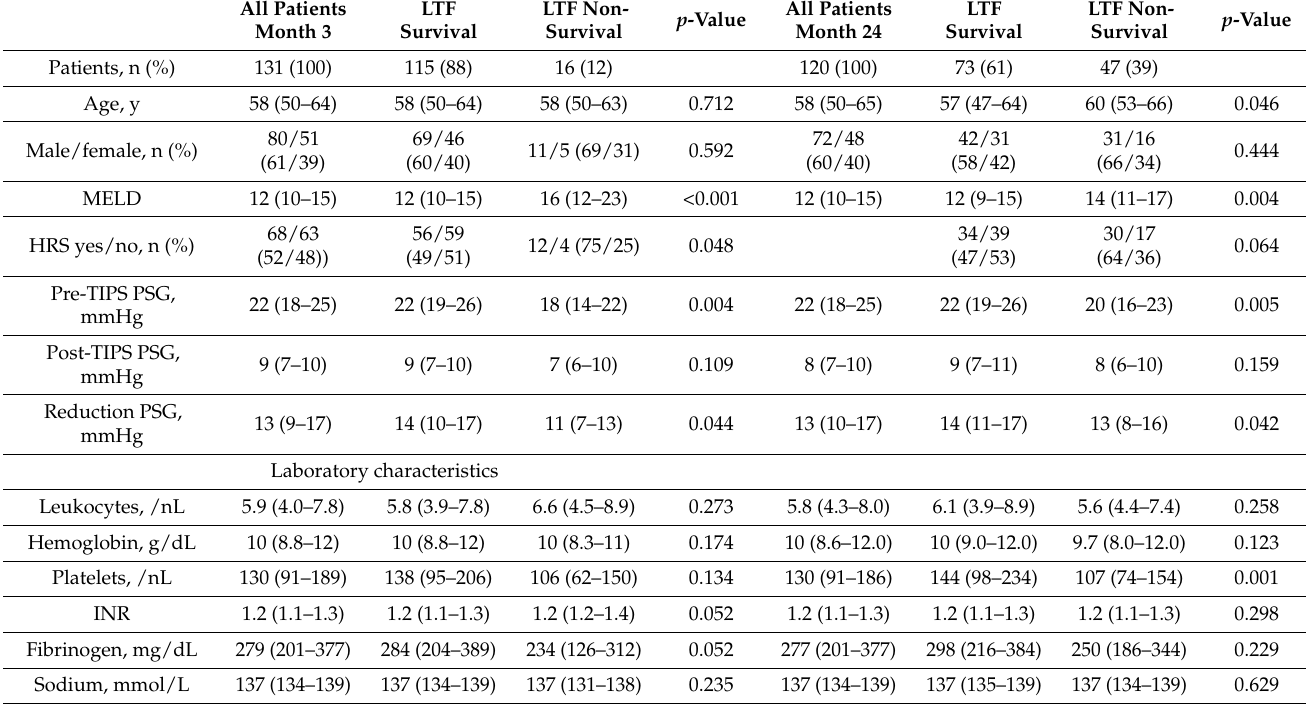
Table 2. A. Demographic and clinical characteristics at baseline by short-term LTF survival (3 months) and long-term LTF survival (24 months) after TIPS in 131 patients.